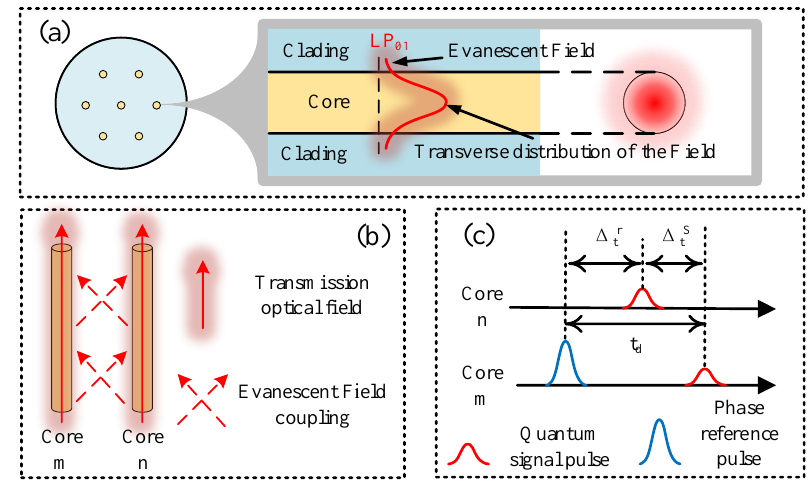
Figure 1. Multi-core fiber and the illustration of inter-core crosstalk. ( a ) A common 7-core MCF and the transverse distribution of the optical field in a single core. ( b ) The inter-core crosstalk between two cores. ( c ) The time delay of pulses between two cores. ∆ r pulse in core m and the most nearby quantum signal pulse in core n . ∆ s quantum signal pulse in core m and the most nearby quantum signal pulse in core n . t d is the time delay between quantum signal pulse and phase reference pulse in the same core and t d = ∆ s < 0 for the case in ( c We assume ∆ r t